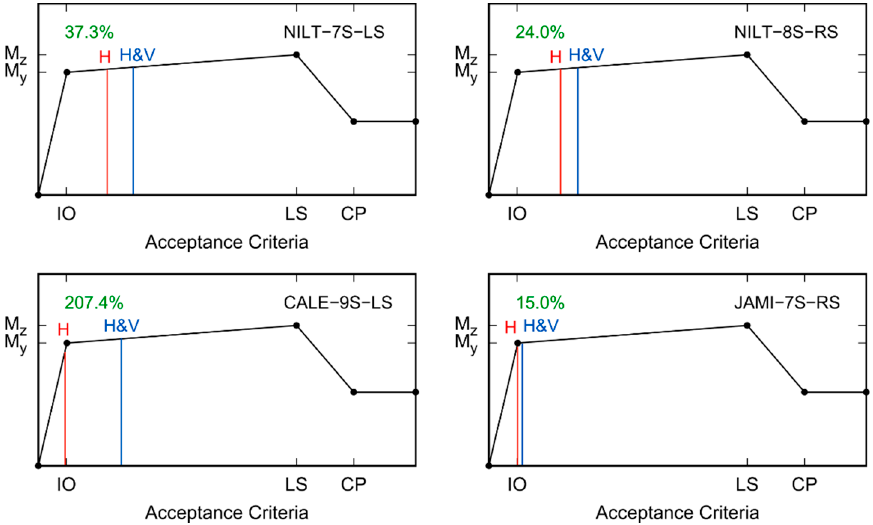
Figure 17. Examples of acceptance criteria for the 10-story building. Part 1.